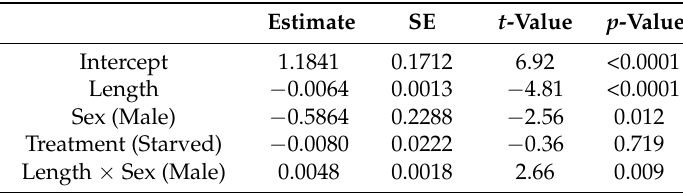
Table 3. Parameter estimates from the linear model of the brain-intestine index (BII), with statistical summary. SE = standard